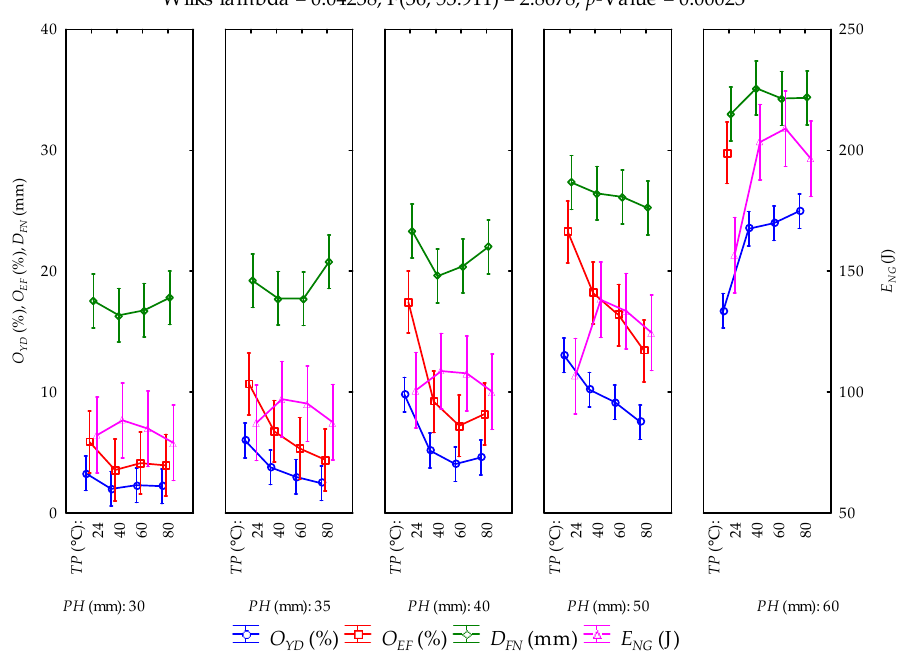
Figure 4. Least square means of the calculated parameters and their factors' interactions (vertical bars denote 95% confidence interval).